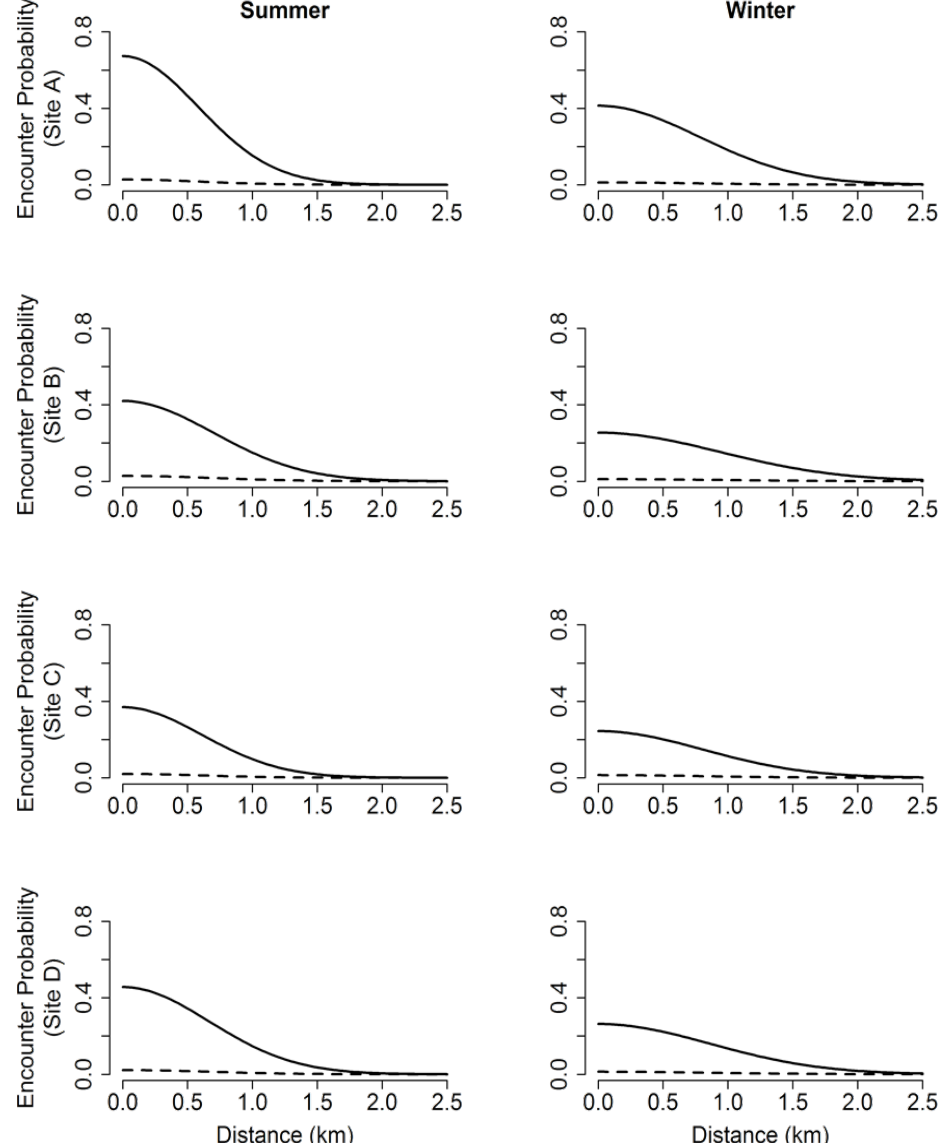
Figure 5. Half-normal detection functions of each baited (solid lines) and passive (dashed lines) camera array site, by season (summer 2015 and winter 2016), describing how the encounter probability of white-tailed deer ( Odocoileus virginianus ) changes as a function of distance (km) from camera at study sites in southwestern Georgia, USA.